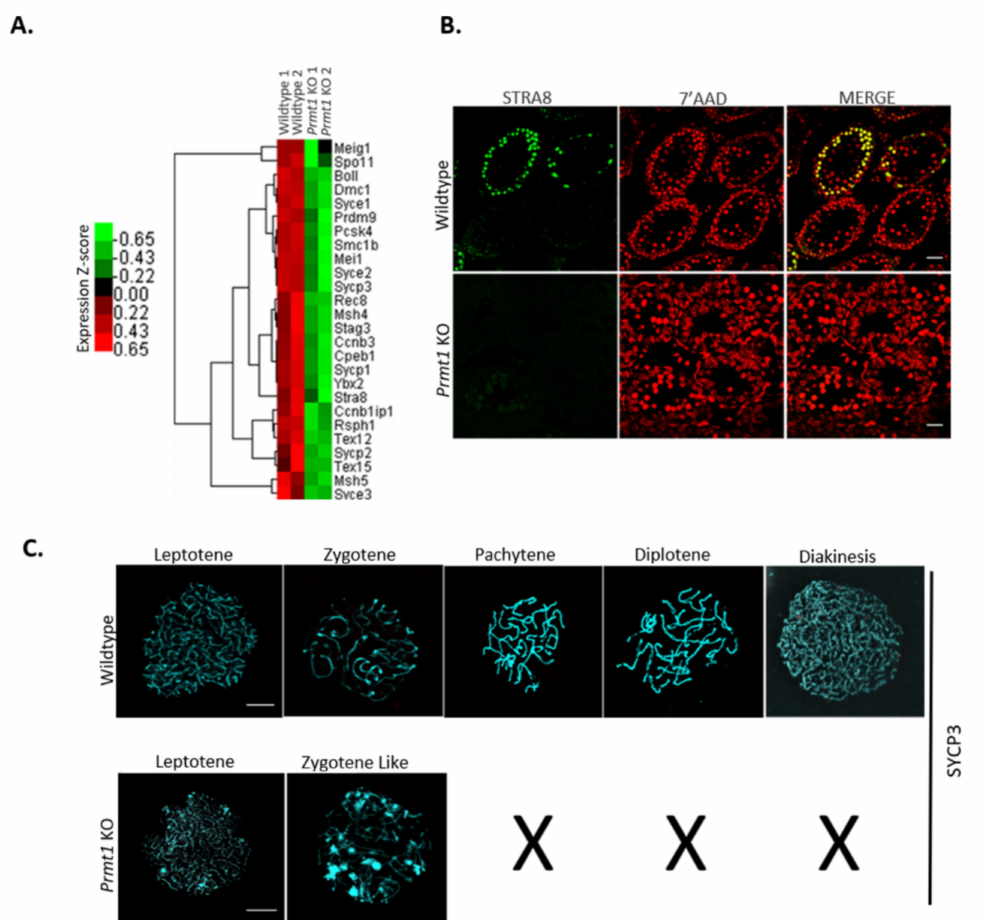
Figure 4. PRMT1 deficiency leads to aberrant meiosis in germ cells of male mice. ( A ) Heatmap showing the differentially expressed meiosis-specific genes between wildtype and Prmt1 KO testes on P8. Twofold expression difference and p = 0.05 as the cut-off. ( B ) Immunofluorescence staining of stimulated by retinoic acid gene 8 (STRA8) in wildtype and Prmt1 KO testes on P12. Scale bar, 50 µ m. ( C ) Immunofluorescence staining to detect the synaptonemal complex protein-3 (SYCP3) on the nuclear surface spreads of spermatocytes from the wildtype and Prmt1 KO testes on P21. Scale bar, 500 µ